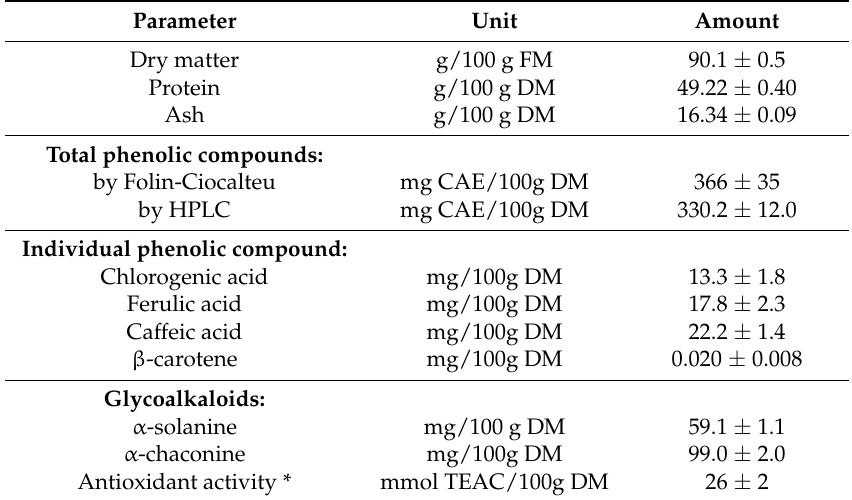
Table 1. Content of bioactive compounds, as well as antioxidant activity of